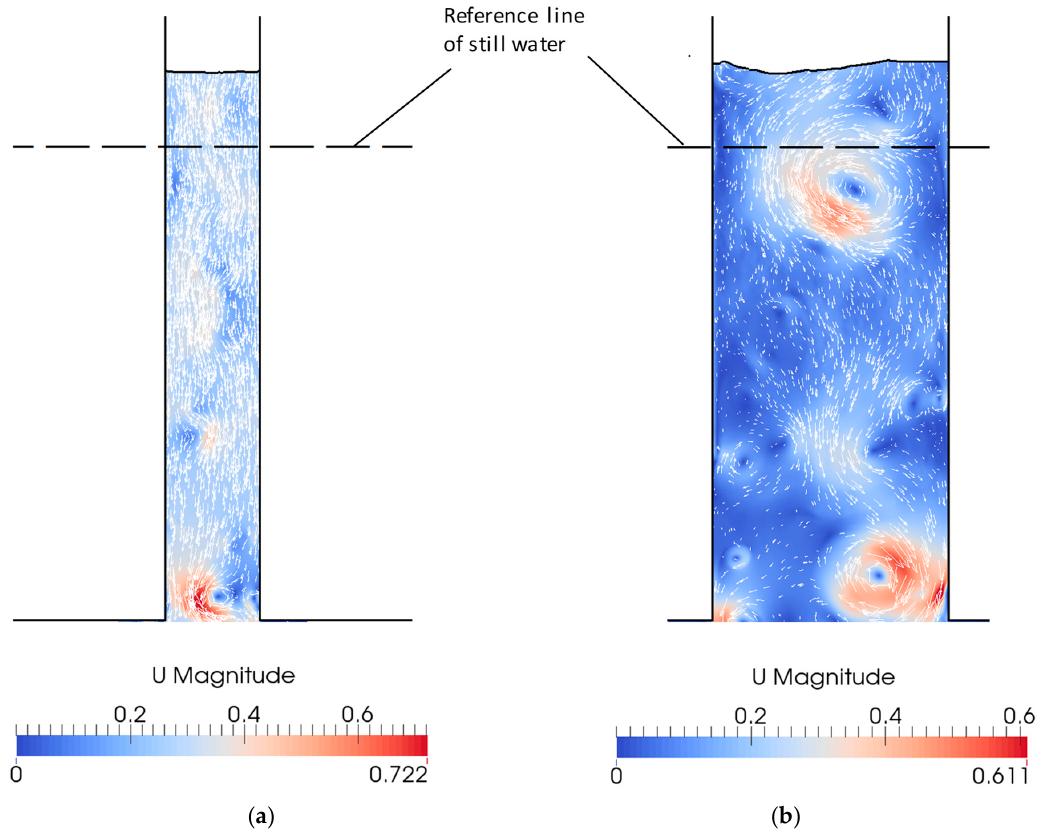
Figure 21. The transverse flow in the gap becomes violent as the gap width increases. ( a ) the velocity profile of case C6; ( b ) the velocity profile of case